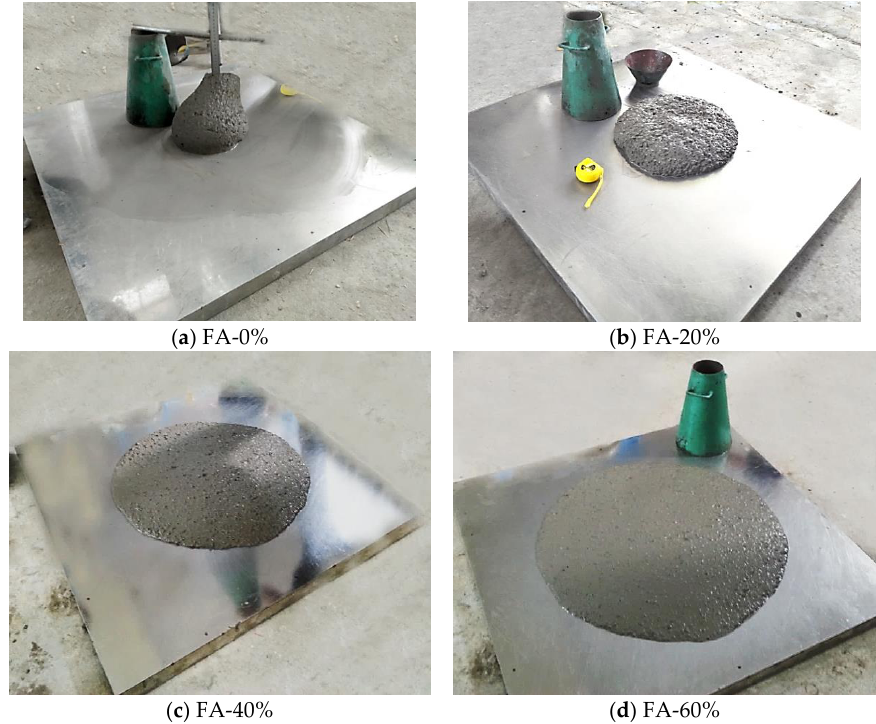
Figure 7. Slump flow tests of the SCC concrete mixture.